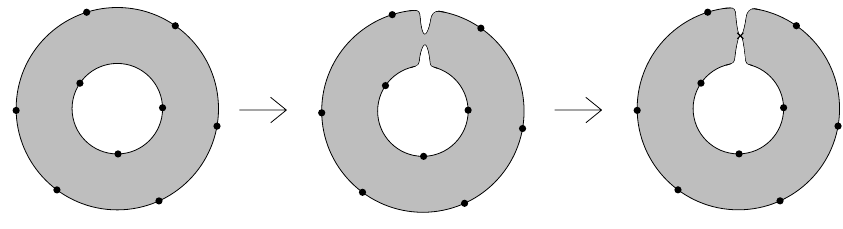
Figure 3 . Example of a non-separating degeneration at